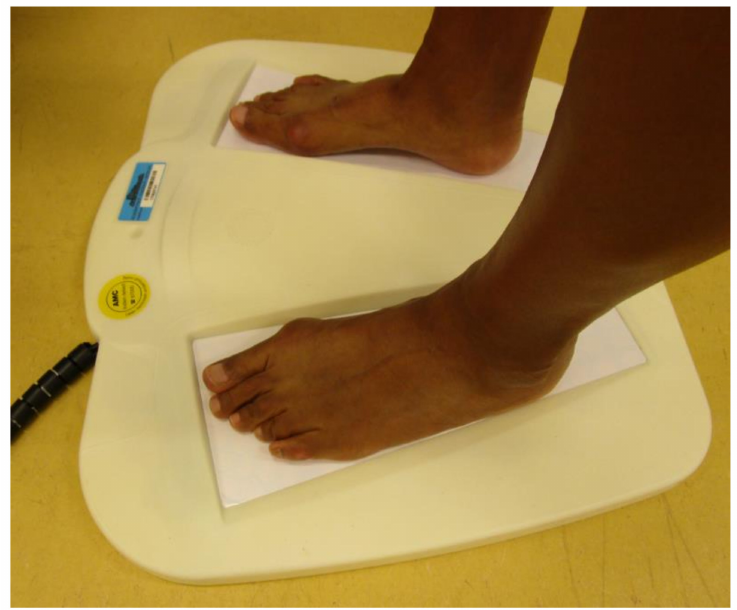
Figure 1. The foot temperature measurement platform system, showing the placement of the feet on the